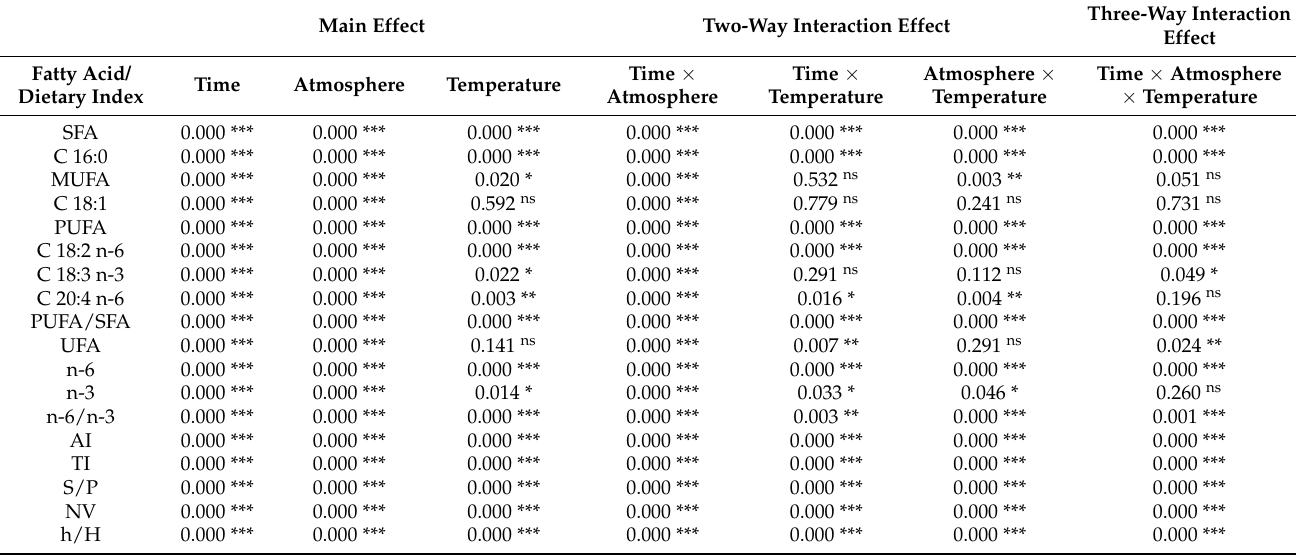
Table 2. The results of the three-way variance analysis (ANOVA with interactions)— p value for the F test. Main